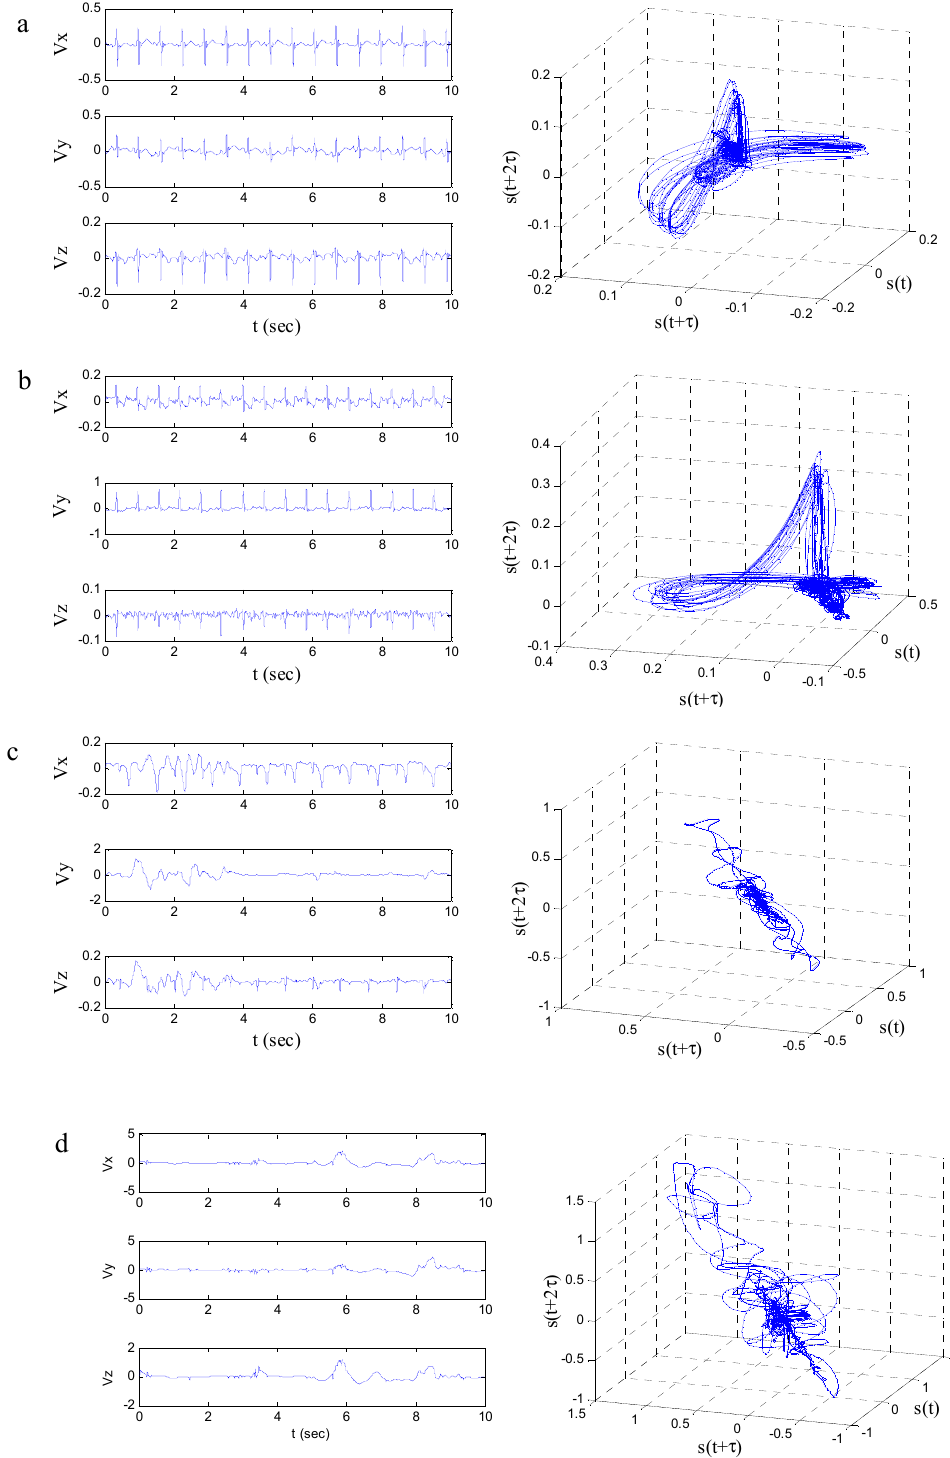
Figure 6. Three-lead VCG signals by realistic 12-lead ECG signals transformation and reconstructed trajectories of fused results. ( a – d ) are results of the signal of No.1027085, No.1075113, No.1027085, and No.1075113,